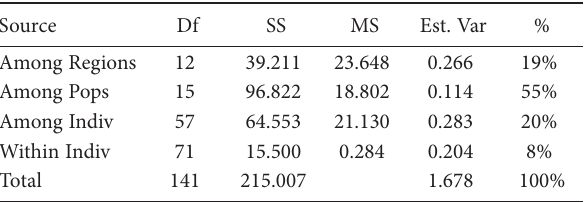
Table 4. Analysis of molecular variance (AMOVA) of the studied species.